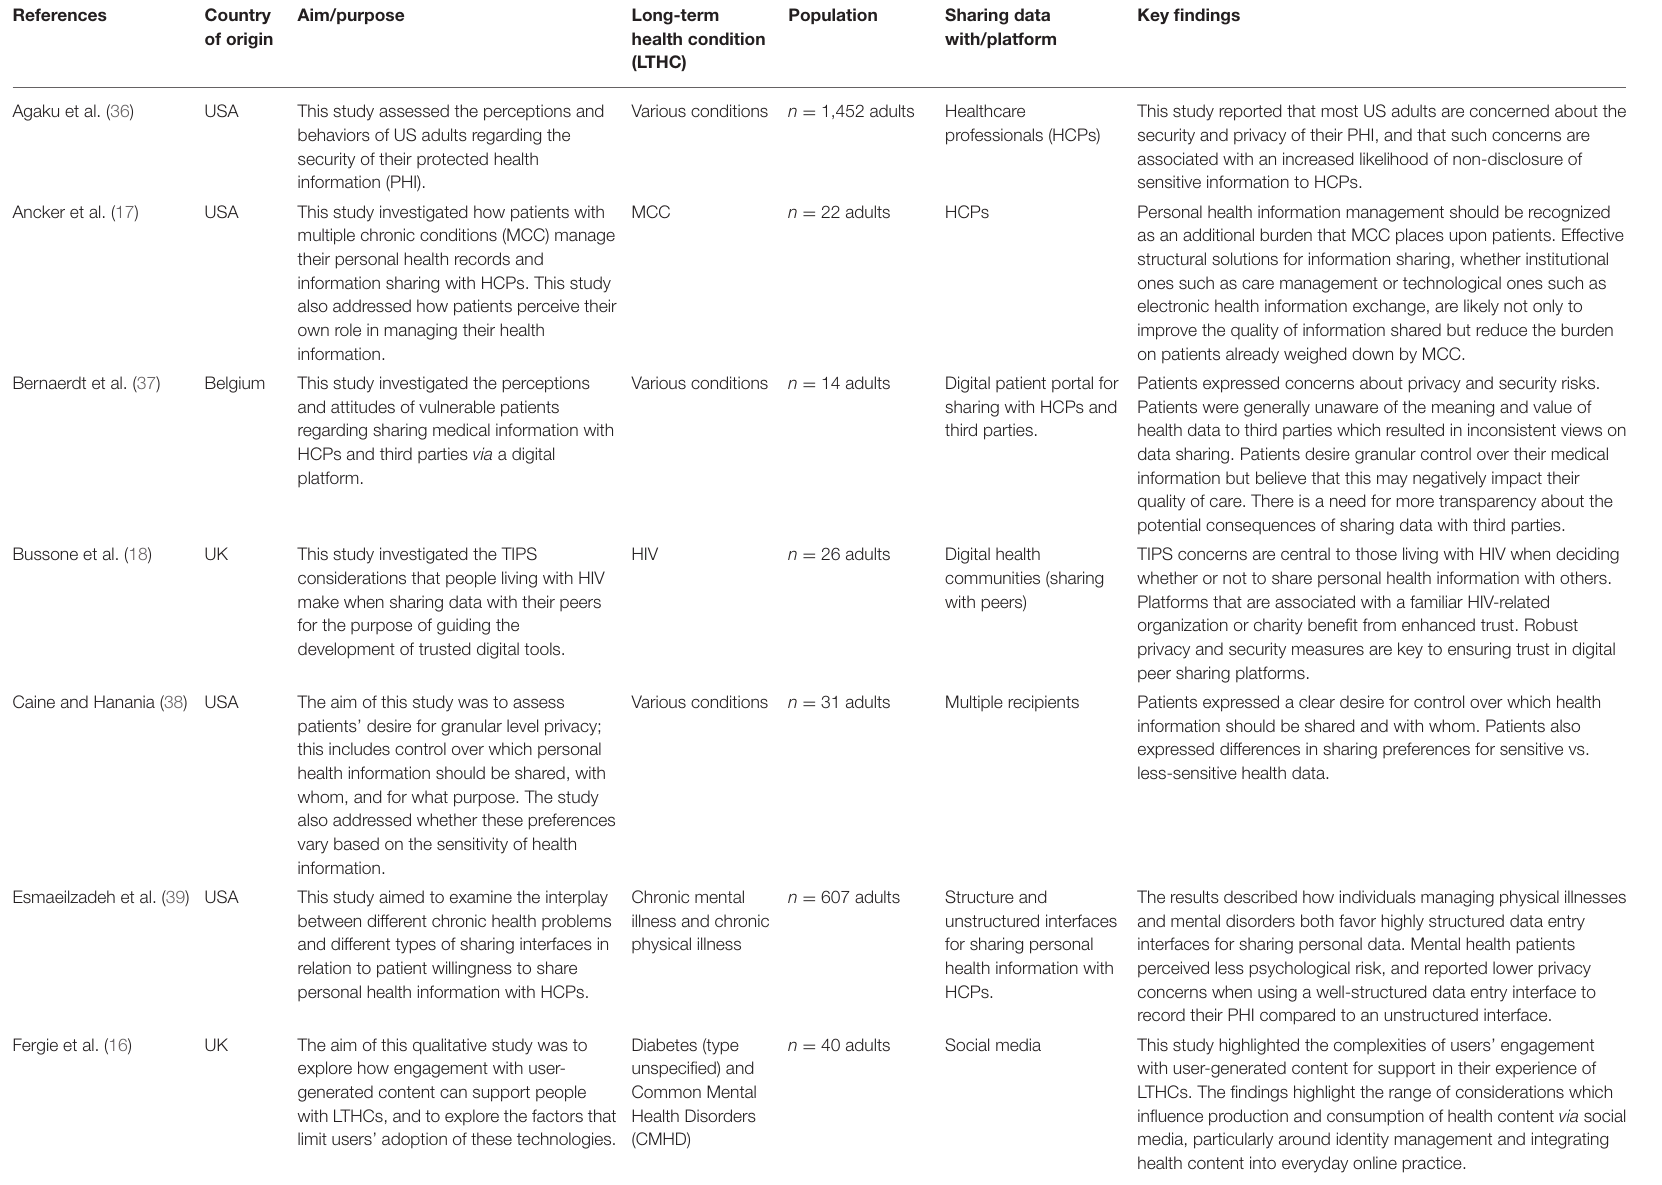
TABLE 2 | Included papers